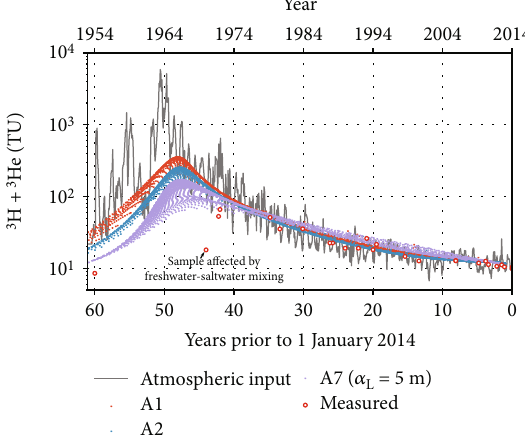
Figure 8: Comparison of the 3 H concentration in precipitation with time (same data as shown in Figure 2(b)) to the sum of the simulated and measured 3 H and 3 He concentrations in groundwater versus τ for simulations A1 (red dots), A2 (blue dots), and A7 with α L = 5 m (purple dots). Each dot represents the simulated value for a model cell. Only values of cells or samples with less than 2.5% seawater are shown.